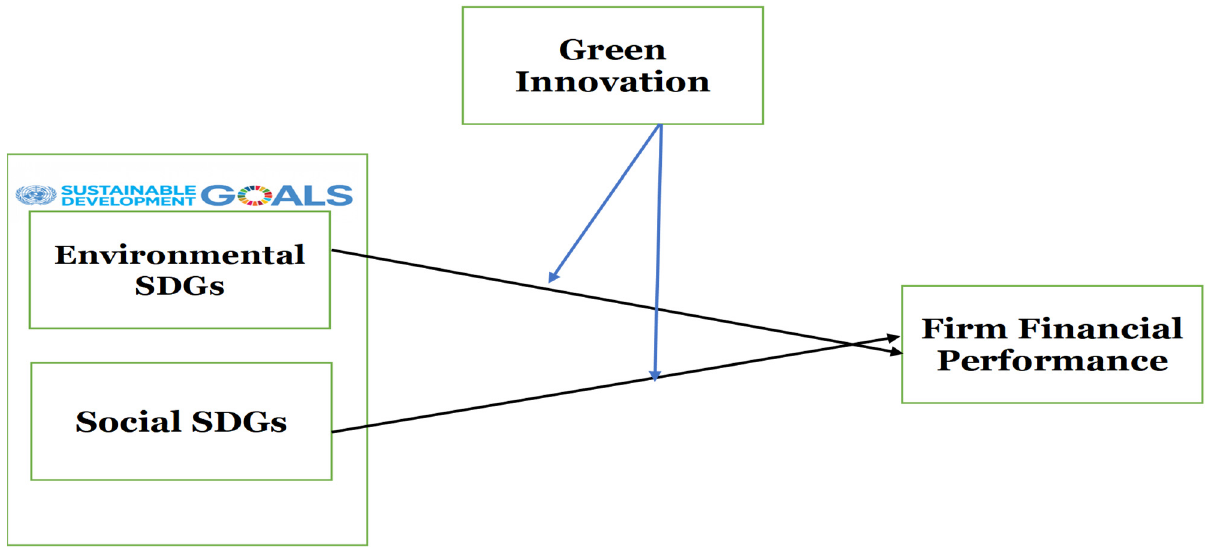
Figure 2. Moderation: Green innovation over SDGs and firms’ financial performance. The current literature on green innovation has a different synonym: ecological, envi- ronmental, and eco-innovation are used by various researchers (Costanza et al. 2016) to integrate—in different contexts—performance measurement criteria. Ultimately, most re- search findings suggest that green innovation decreases the environmental burden, creating value for related stakeholders and strengthening business